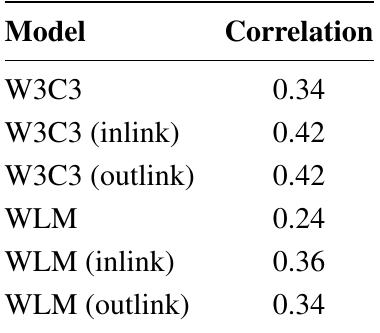
Spearman rank correlations with backward associative strength for DRM lists, after disaggregating WLM inlink/outlink measures (N = 55).